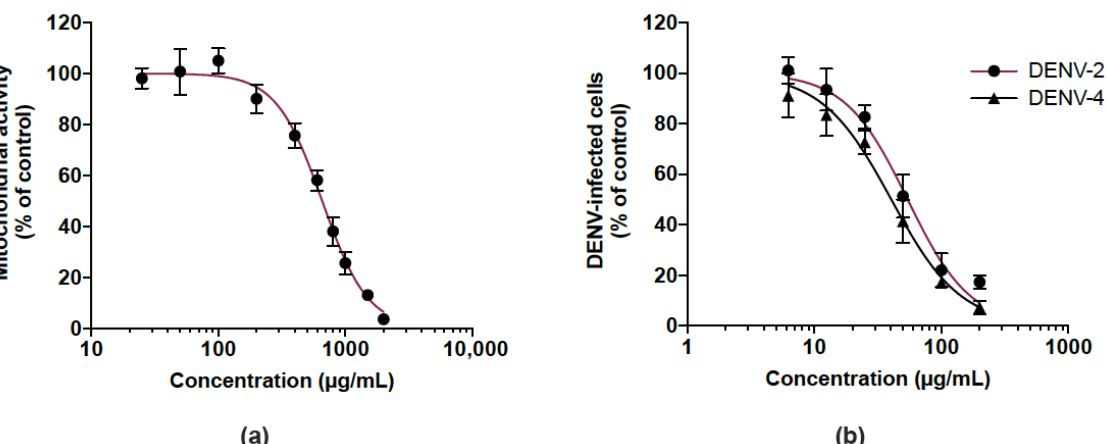
Figure 6. Cranberry pomace extract exhibits antiviral effect against two DENV serotypes. ( a ) Mito- chondrial activity of Huh7.5 cells incubated with different concentrations of CP extract. Cells were grown in the presence of increasing concentrations of CP extract (25 to 2000 µg/mL) for 48 h. The mitochondrial activity of the cells was assessed by MTT assay. ( b ) Huh7.5 cells were infected for 48 h with DENV-2 or DENV-4 (MI 0.5) in the presence of various non-cytotoxic concentrations of CP extract (6.25 – 200 µg/mL). Flow cytometric analysis was performed using the anti-flavivirus E mAb 4G2. Data represent means ±SD of three independent experiments.